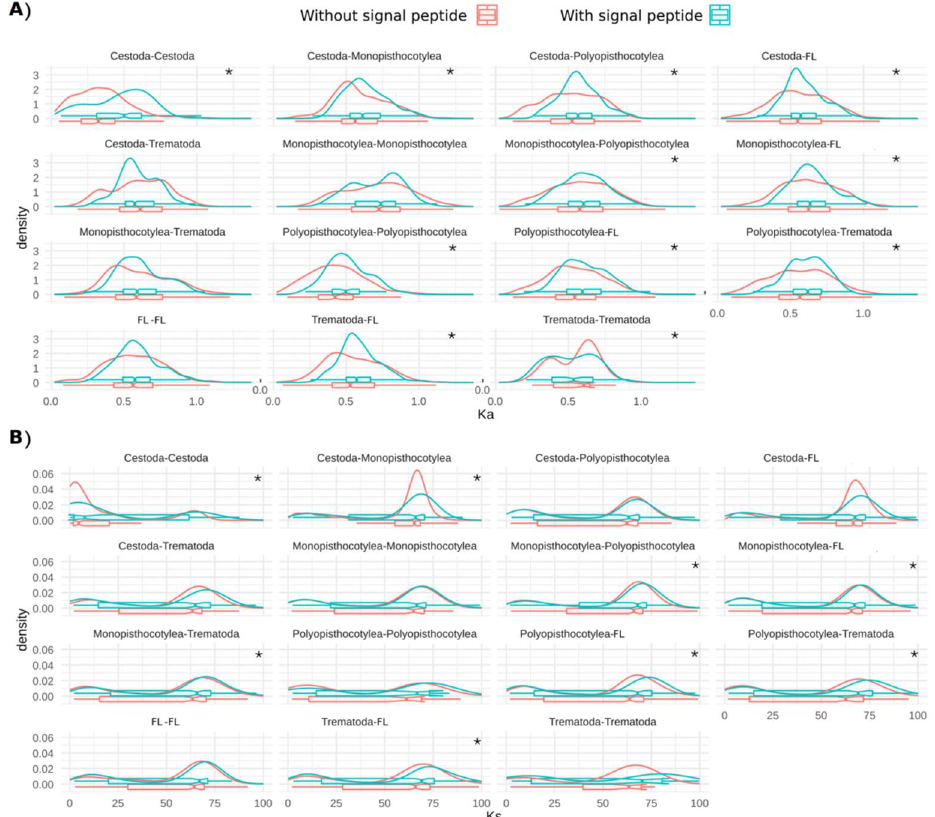
Figure 7. The distribution of ( A ) Ka and ( B ) Ks in multiple-copy OGs of peptidases and inhibitors of platyhelminths with/without predicted signal peptides. FL indicate the free-living platyhelminths Bothrioplana semperi and Schmidtea mediterranea . * indicate p < 0.05.